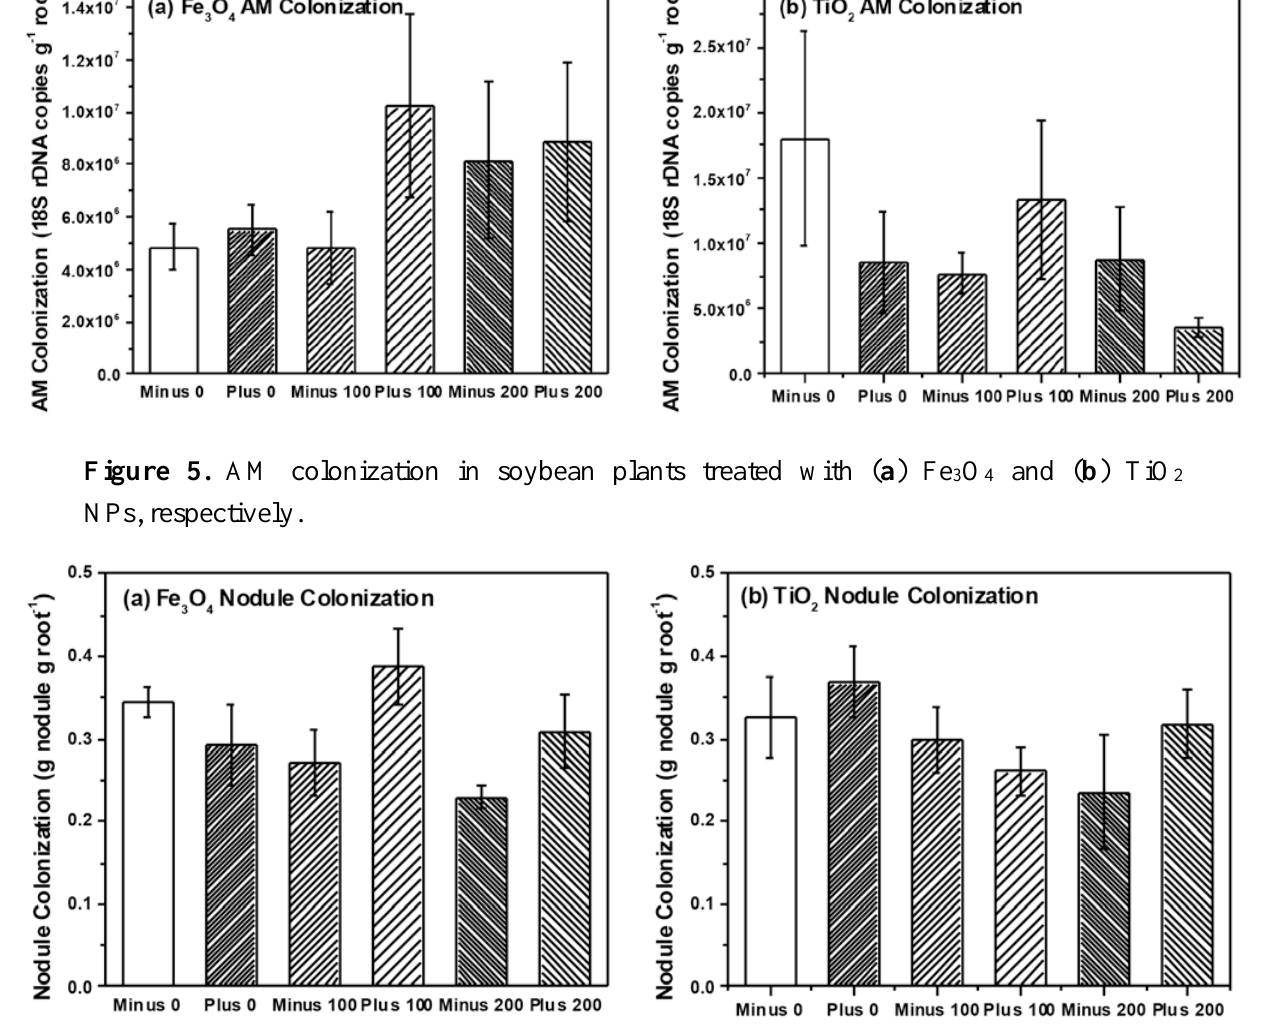
Figure 6. Nodule colonization of soybean plants treated with ( a ) Fe 3 O 4 and ( b ) TiO 2 ,